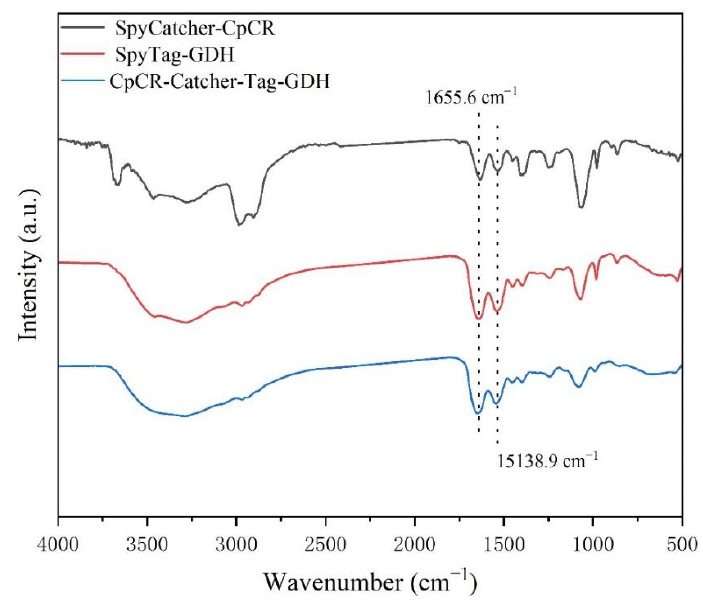
Figure 18. Infrared spectrum.